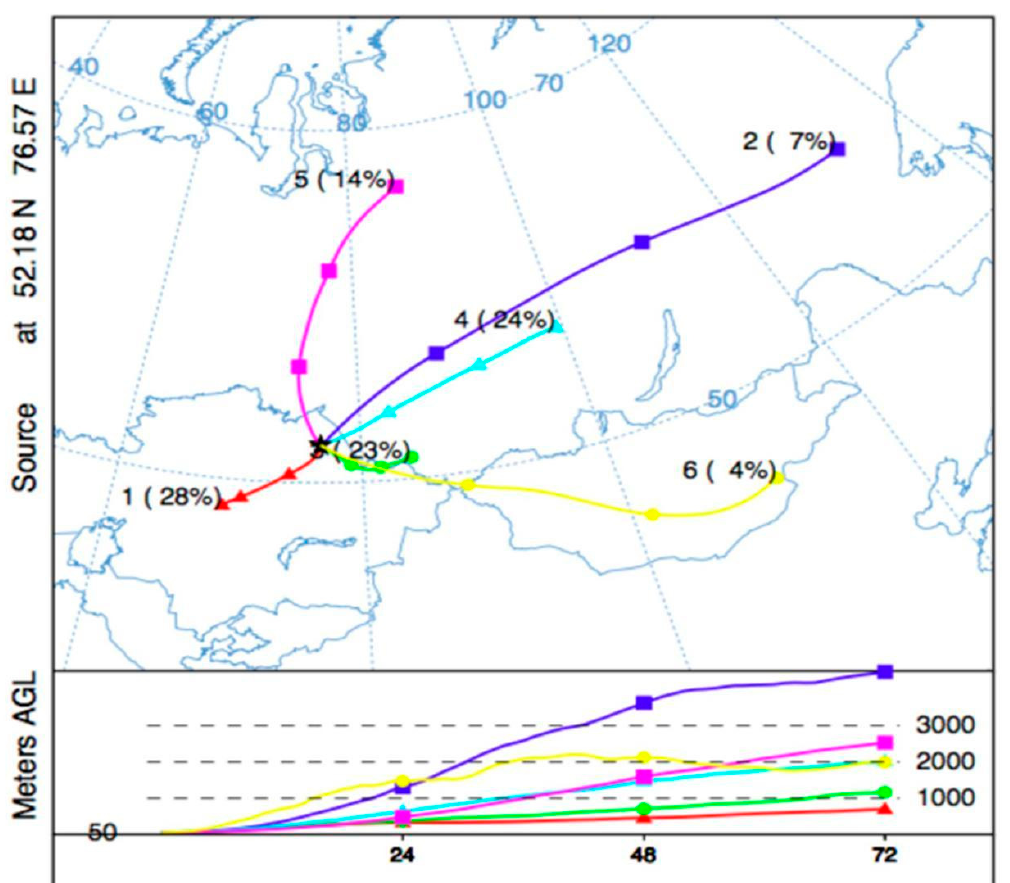
Figure 8. Optimum trajectory clusters (n = 6) for non ‐ heating period.